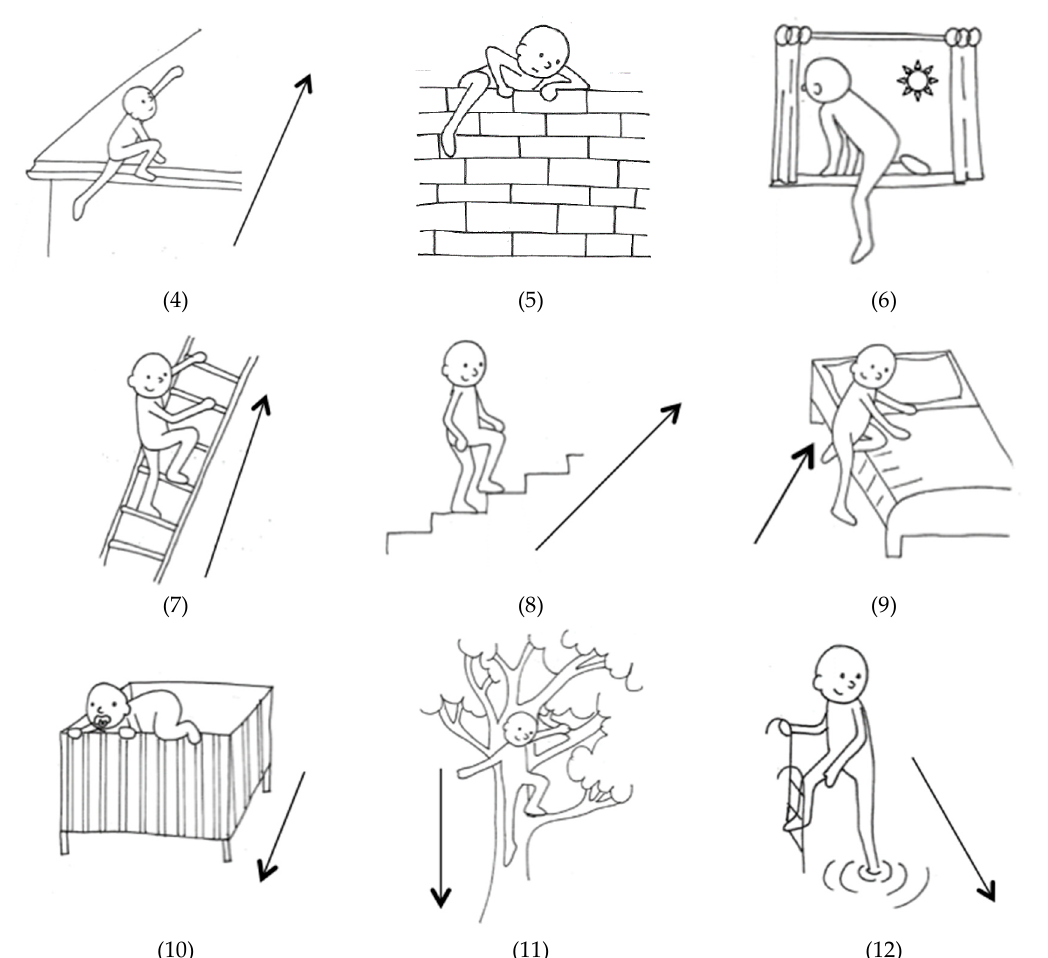
Figure 2. Drawings 1–12, depicting an individual moving in different environments and directions (potentially describable with the verb climb )